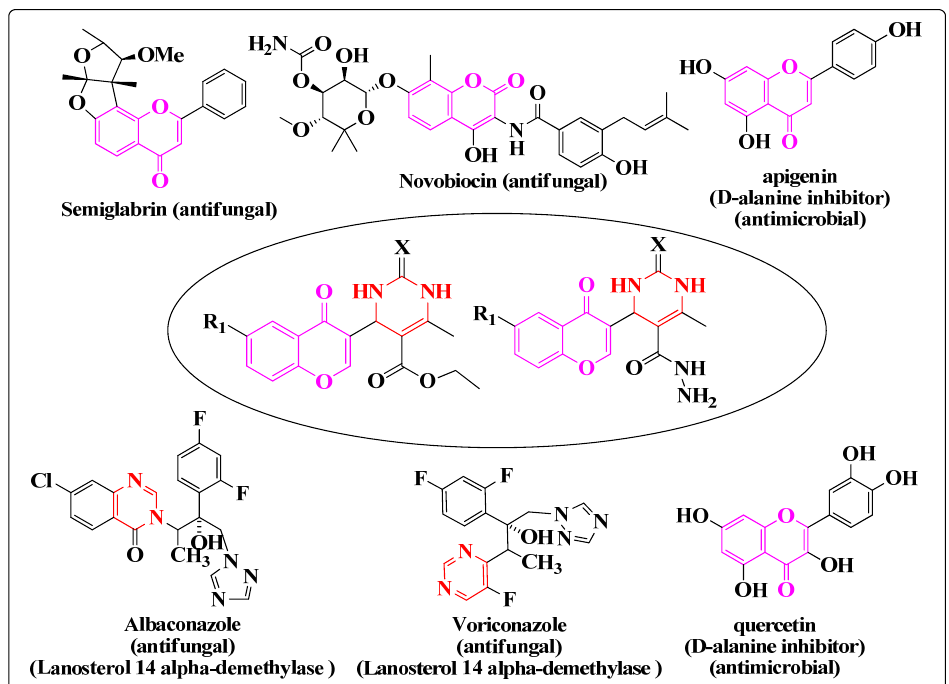
Scheme 1. The design protocol for the synthesis of the target molecules.